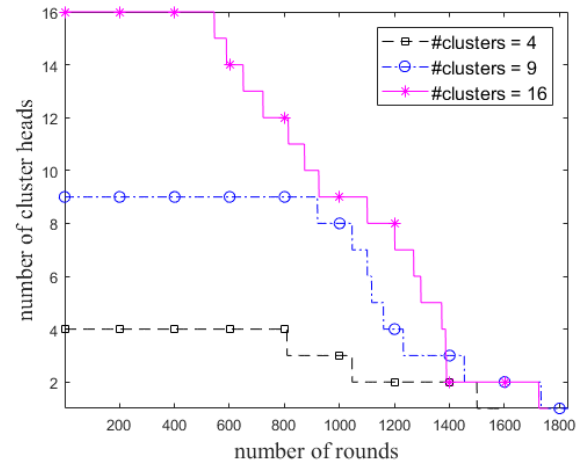
Figure 6. Number of elected cluster heads in each round in ECCR.